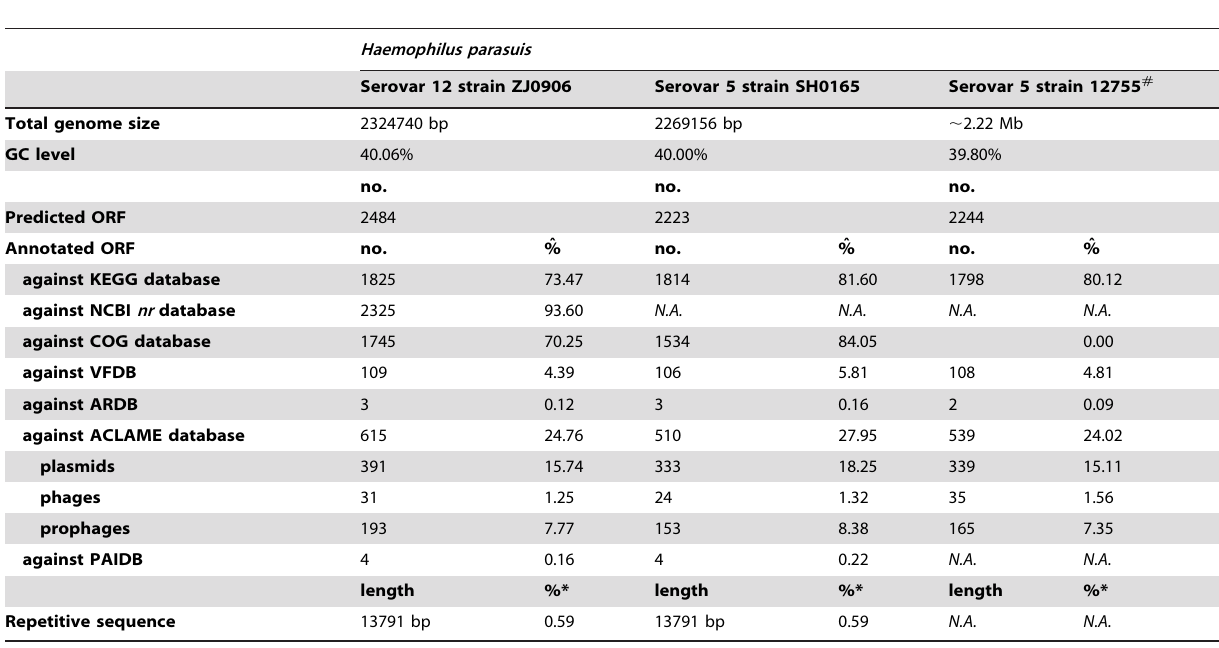
Table 1. Summary of H. parasuis strains ZJ0906, SH0165 and 29755